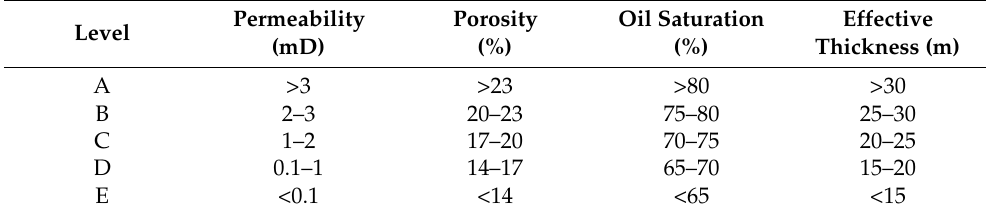
Table 5. Parameter range of different physical sweet